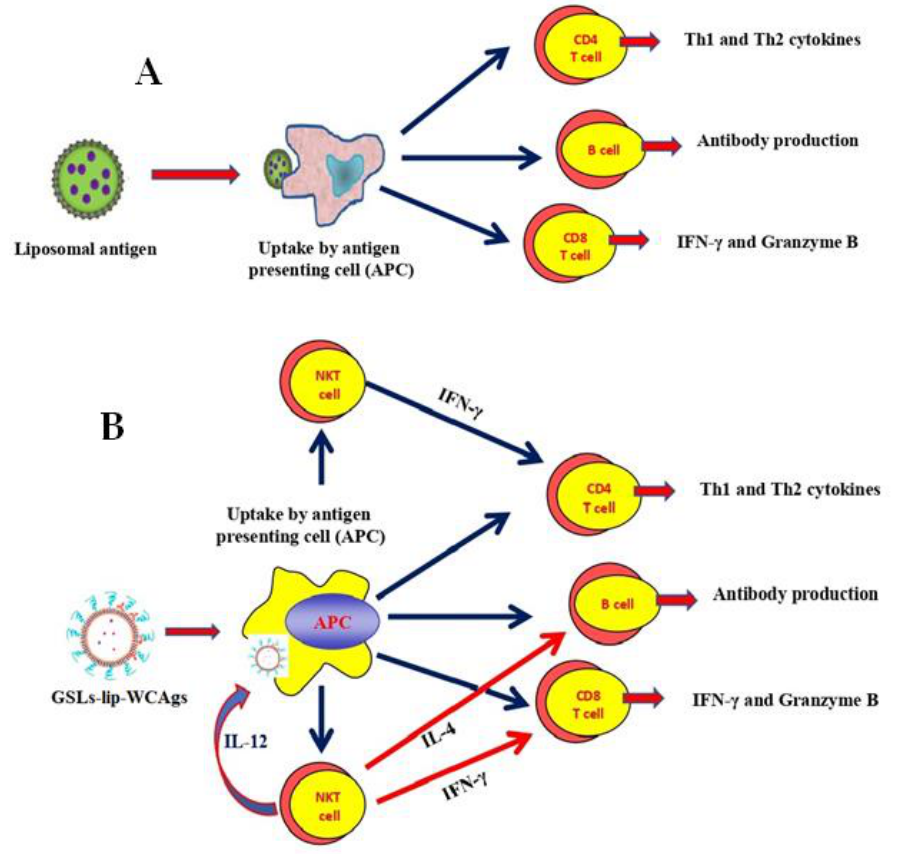
Figure 1. ( A ) Liposomal antigens can induce humoral and cell‑mediated immune responses. ( B ) In addition to activating the antibody and cell‑mediated immune responses, antigens encapsulated in GSLs‑bearing liposomes can induce NKT cell activation that further potentiates immune responses.